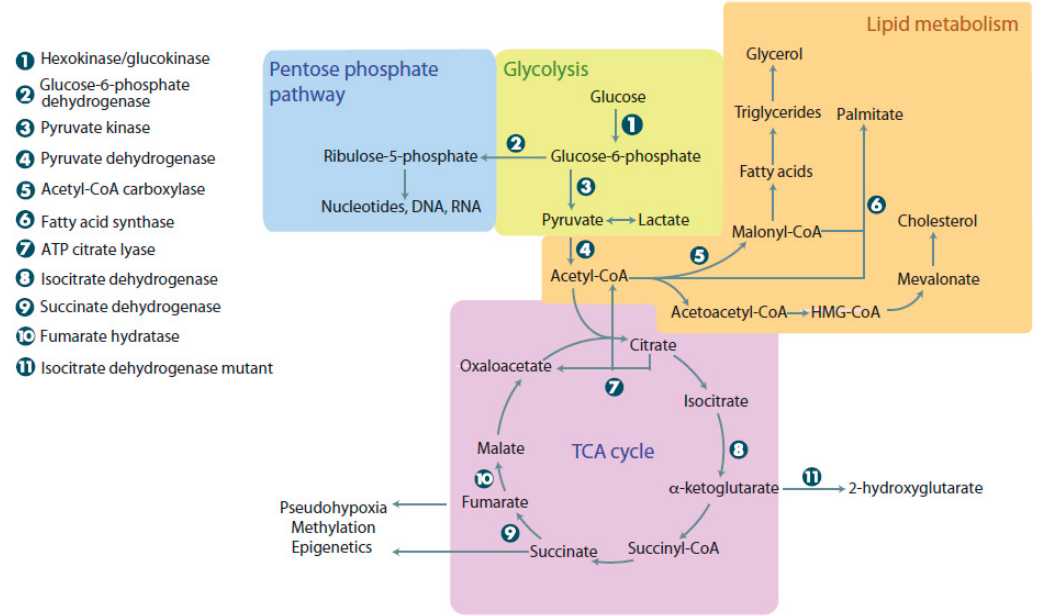
Figure 1. Metabolic pathways in normal and cancer cells. When glucose enters cells, it undergoes glycolysis, linking it to the pentose phosphate pathway, lipid metabolism, and the tricarboxylic acid (TCA) cycle. The pentose phosphate pathway can be used to make nucleotides, DNA, and RNA. Lipid metabolism is used for energy and synthesis of membrane components. The TCA cycle provides cells with intermediates for the electron transport chain and links many other metabolic reactions that occur in the cell. Cancer cells with mutations in metabolic enzymes have increased levels of 2-hydroxyglutarate, succinate, and malate, resulting in adverse cellular outcomes. ATP: Adenosine triphosphate.